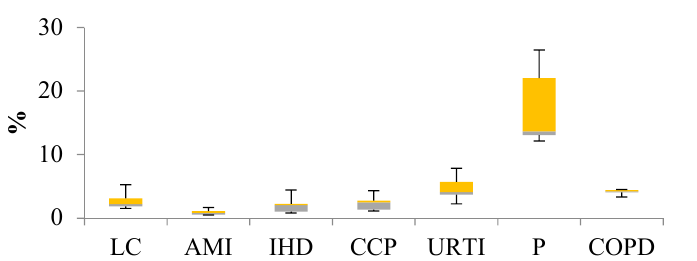
Figure 14. Box-plot analysis of PM 10 contribution to the annual mean disease frequency. The lower (grey) and upper (yellow) limits represent the first (25P) and third (75P) quartiles, and the ends of the whiskers represent the minimum and the maximum values.